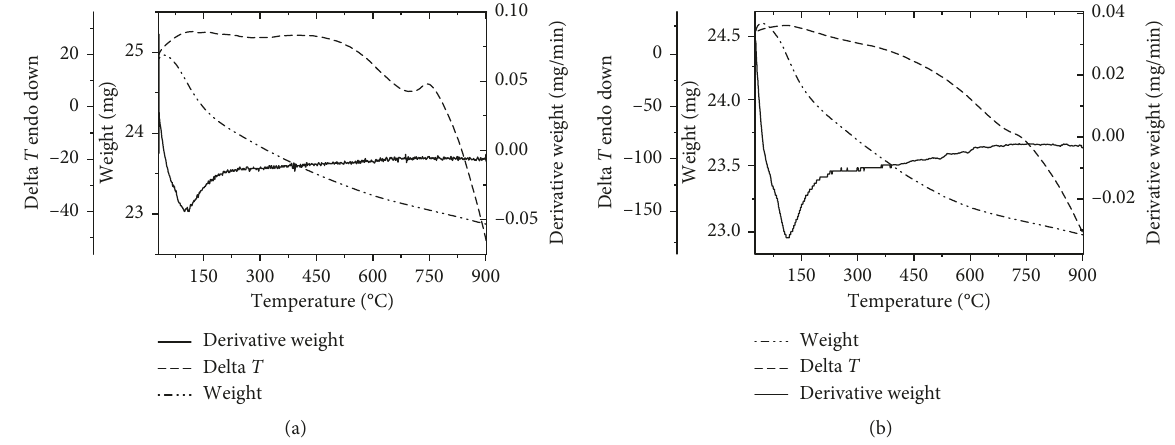
Figure 1: Thermal analysis of the (a) OGP group and (b) GPN group using DTA, TG, and DTG.